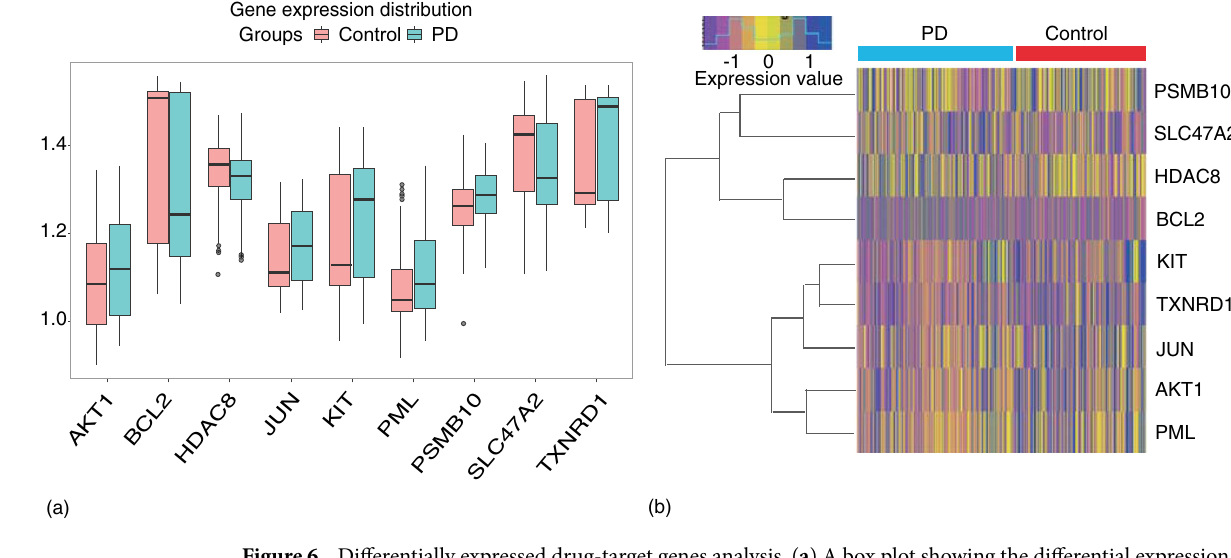
Figure 6. Differentially expressed drug-target genes analysis. ( a ) A box plot showing the differential expression distribution of nine drug-target genes between two groups. ( b ) Heatmap and clustering of nine differentially expressed drug-target